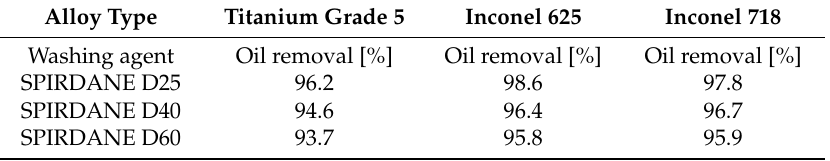
Table 5. Removal percentages of oil residues from swarfs after 60 min using washing